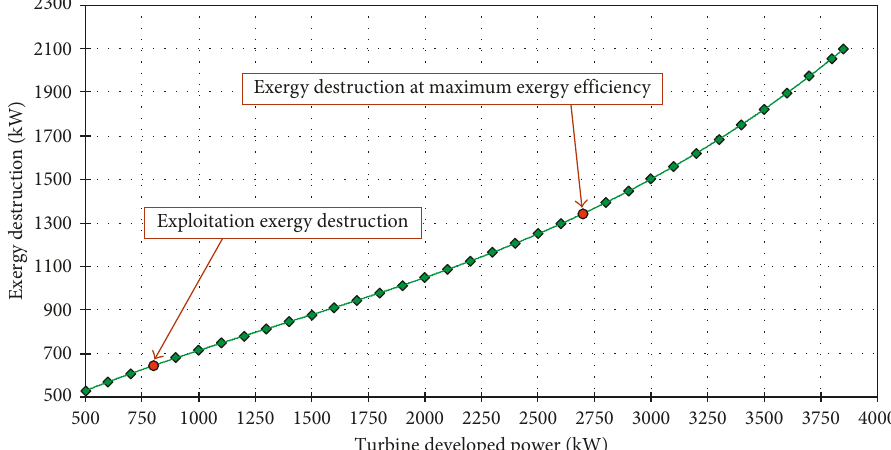
Figure 7: Steam turbine exergy destruction change during the developed power variation—operating point